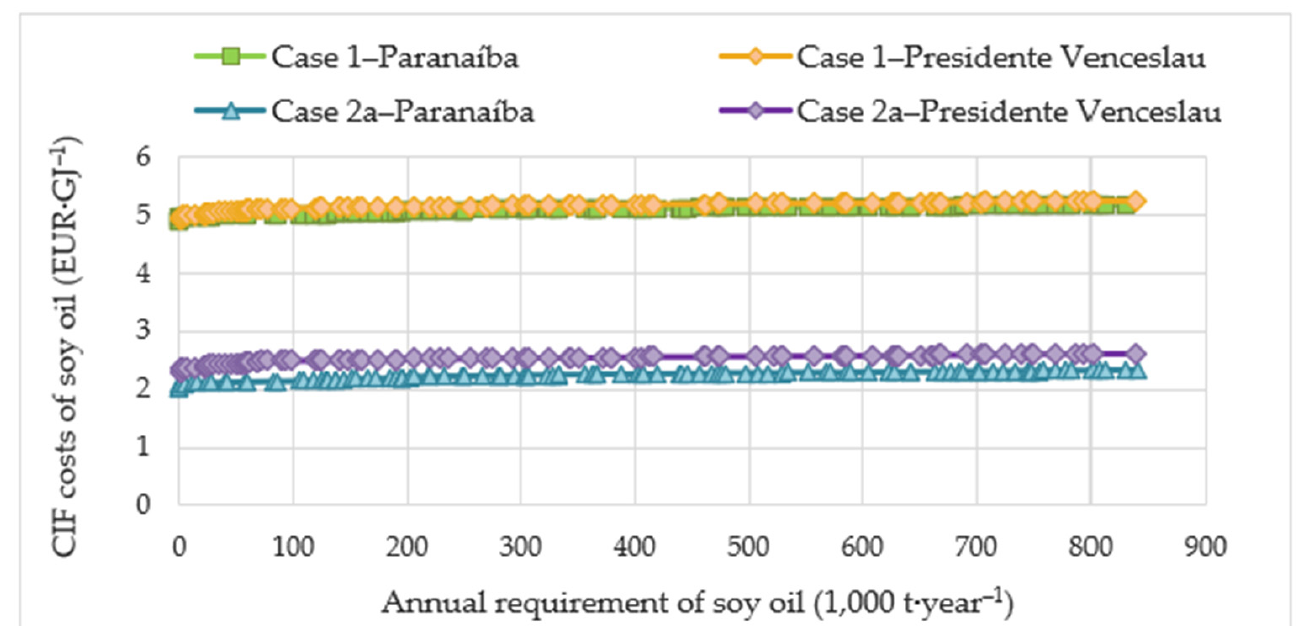
Figure 9. Estimated supply curves of soy oil at REPLAN, for Cases 1 and 2a, from two new producing regions: Paranaíba (MS) and Presidente Venceslau (SP).